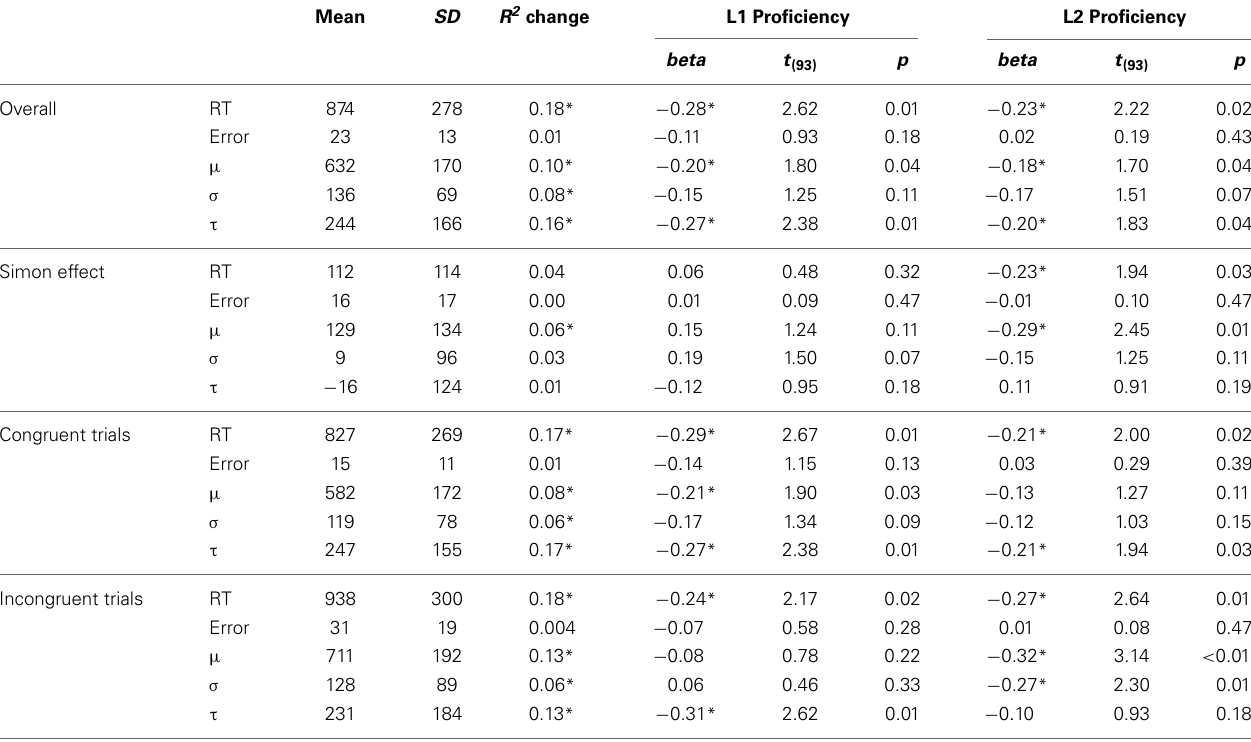
Table 2 | Mean statistics and findings of regression analyses for participants’ performance in the Simon